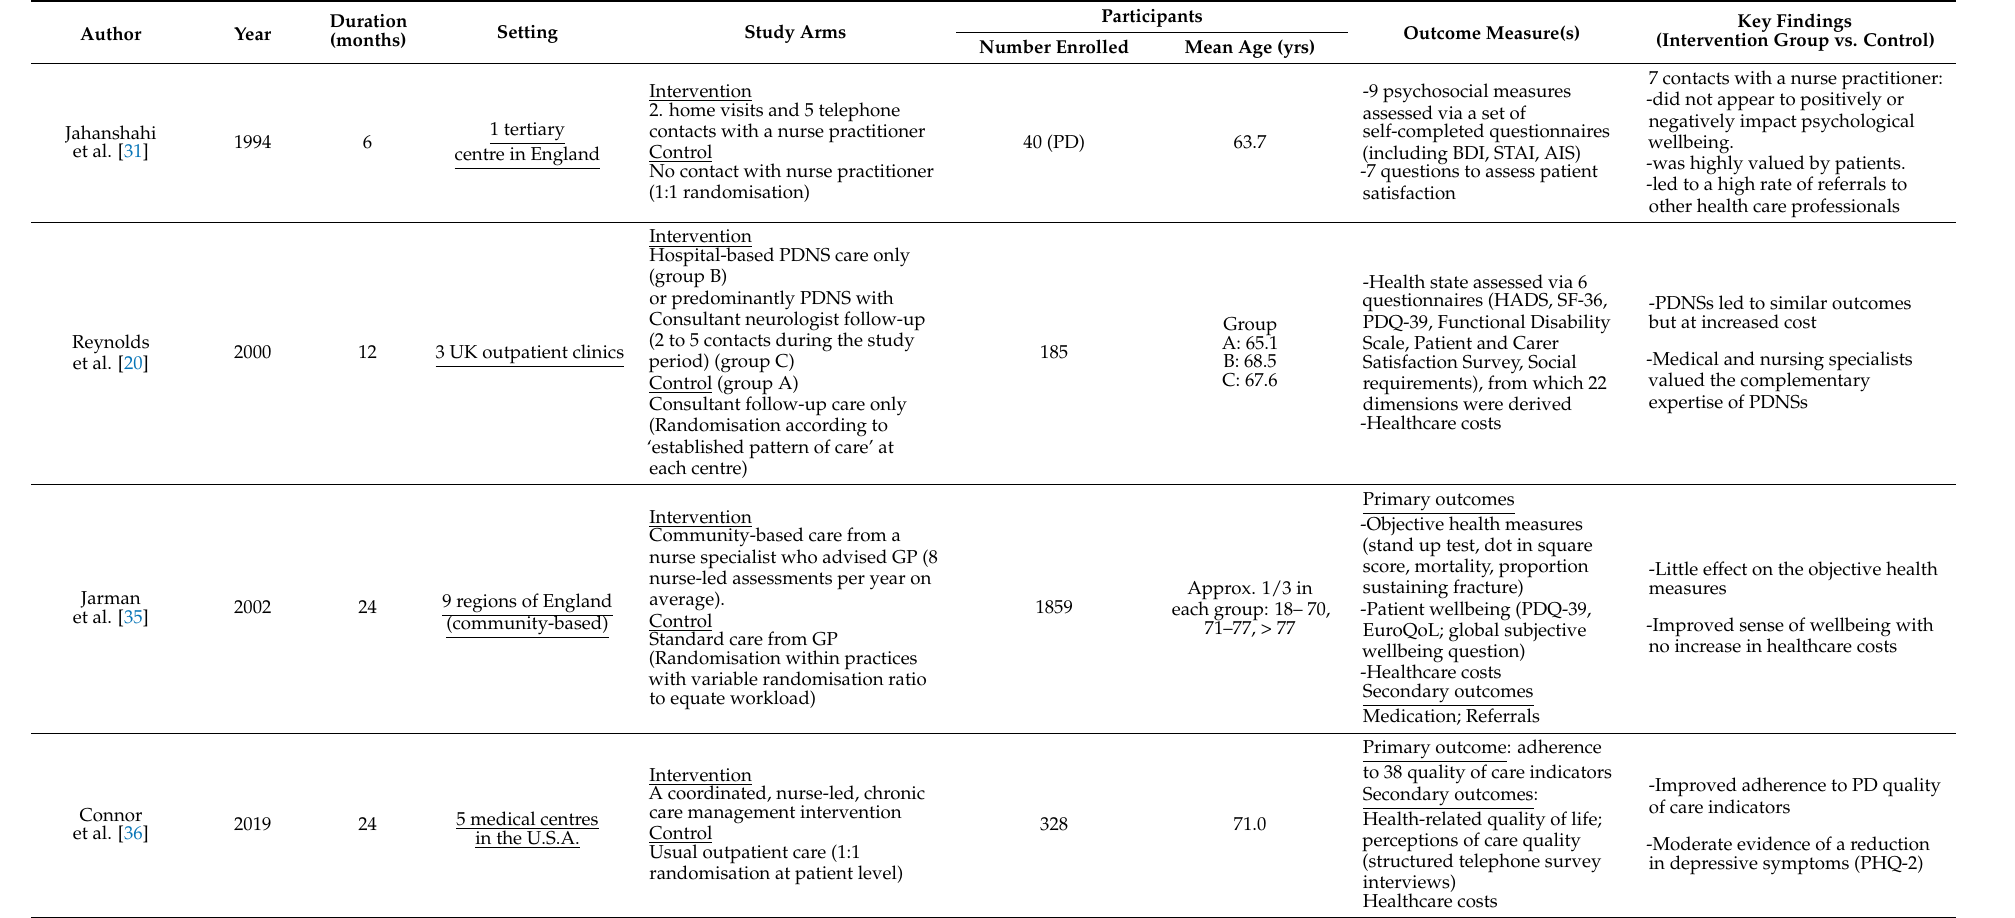
Table 1. Summary of randomised controlled trials of Parkinson’s Disease Nurse Specialist care. BDI, Beck Depression Inventory; STAI, Spielberger Trait Anxiety Inventory; AIS, Acceptance of Illness Scale; PDNS, Parkinson’s Disease Nurse Specialist; HADS, Hospital Anxiety and Depression Scale; SF-36, 36-item short form survey; PDQ-39, Parkinson’s Disease Questionnaire-39; GP, general practitioner, PHQ-2, Patient Health